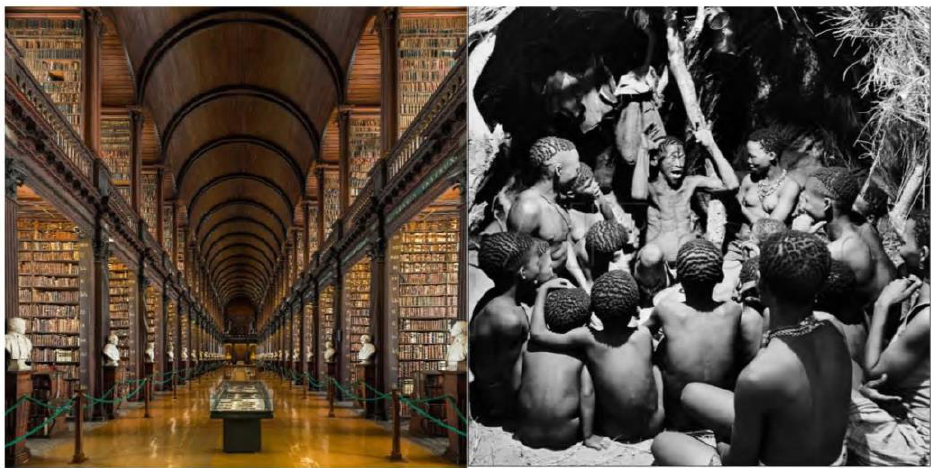
Figure 1. Contrasting ways to store memories—the archive and the story teller. On the left, the Library at Trinity College Dublin (Photo by DAVID ILIFF. License: CC-BY-SA 3.0); the right-hand frame shows a traditional story-teller or Griot, describing, perhaps, what to do on encountering cognate antigen (Photograph: Bushmen, N. R. Farbman for Life magazine, 1946; http://images.google.com/hosted/life/6da6b5c69e36d1ff.html; © Time Inc).